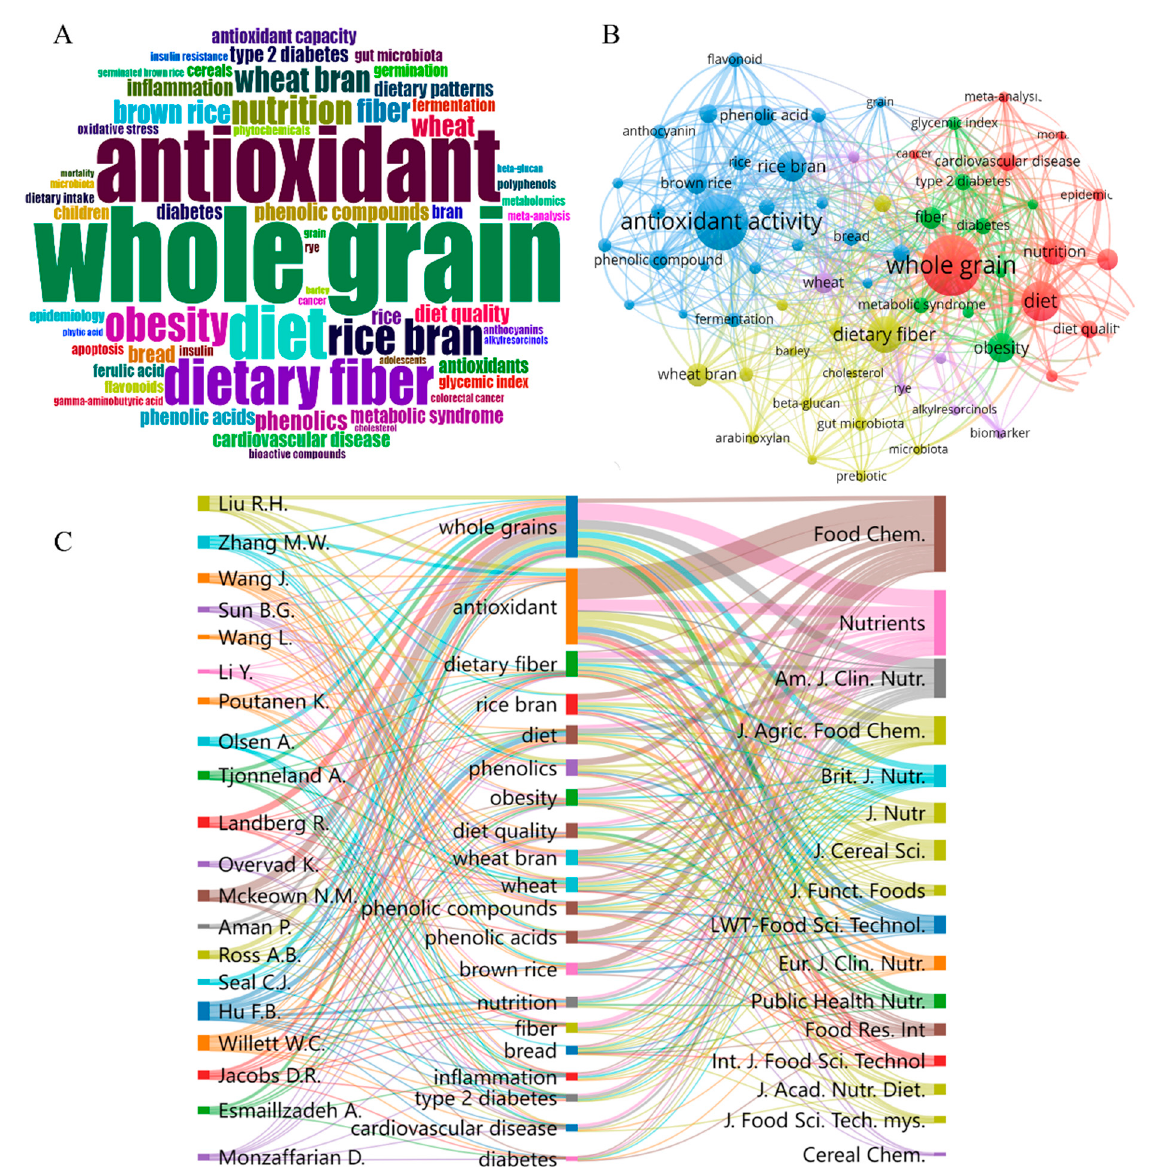
Figure 3. Distribution of hotspot in research on health effects of whole grains. ( A ) Co-occurrence of